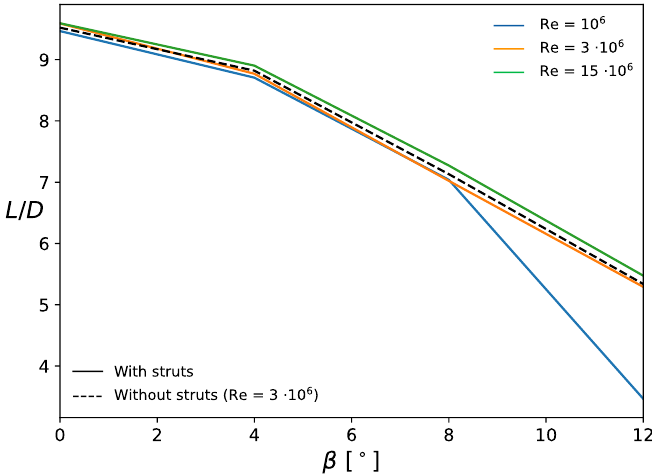
Figure 16. Lift-over-drag ratio as a function of the side-slip angle for α = 12 ◦ . The continuous lines show the results for the wing with struts at different Re and the dashed line highlights the results for the wing without struts at Re = 3 × 10 6 . It